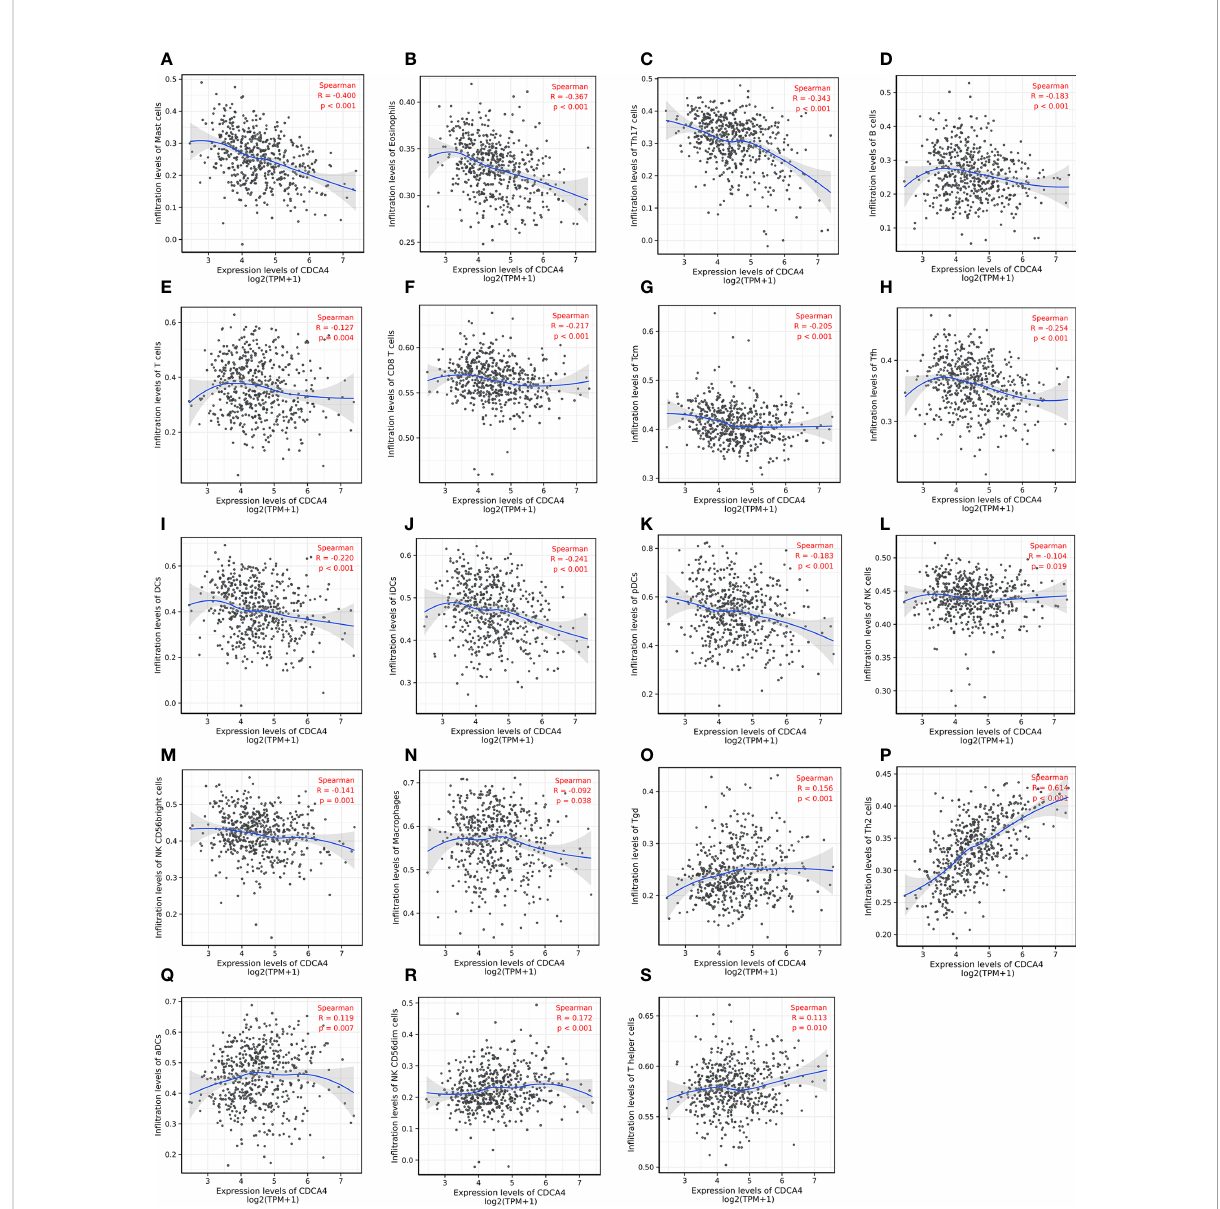
FIGURE 6 Investigation of the correlation between CDCA4 expression and immune cell in fi ltration in LUAD(P<0.05). (A-N) CDCA4 expression was negatively correlated with the in fi ltration of Mast cells, Eosinophils, Th17, B cells, T cells, CD8 T cells, T central memory, follicular helper T cells, DCs, immature DCs, pDCs, NK cells, NK CD56 (bright) cells, and Macrophages. (O-S) CDCA4 expression was positively correlated with T gamma delta, Th2, activated DCs, NK CD56 (dim) cells, T helper cells.Data were assessed by Spearman correlation